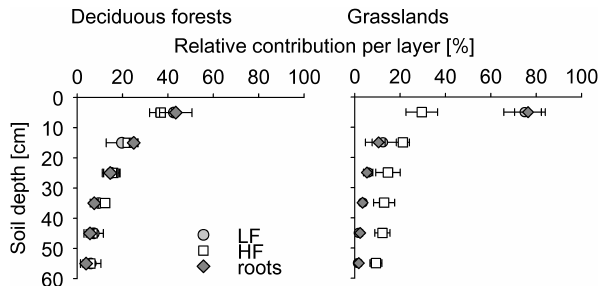
Fig. 5. Relative contributions of 10cm depth increments to total stocks in 0–60cm (100%) of OC with LF (light fraction) and HF (heavy fraction) and roots sorted out during sample preparation. Averages for deciduous forest and undisturbed grassland sites are shown.